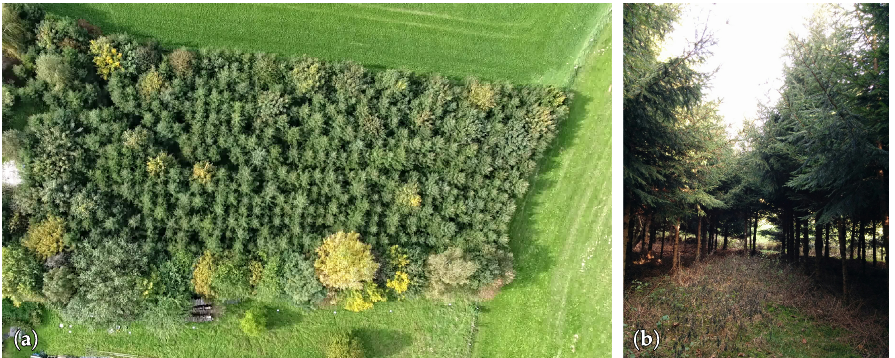
Figure 2. The experimental stand seen on ( a ) a drone image and ( b ) ground level.